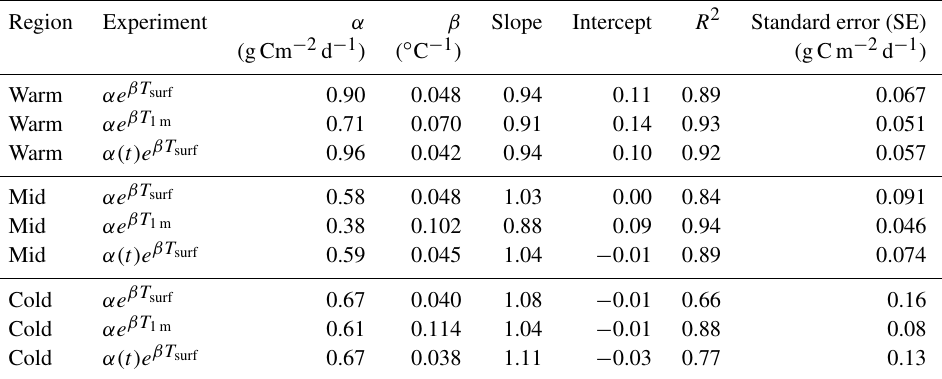
Table 1. Parameters ( α,β ) for one-layer model fits and statistics (slope, intercept, R 2 , standard error – SE) on the data–model mismatch of these